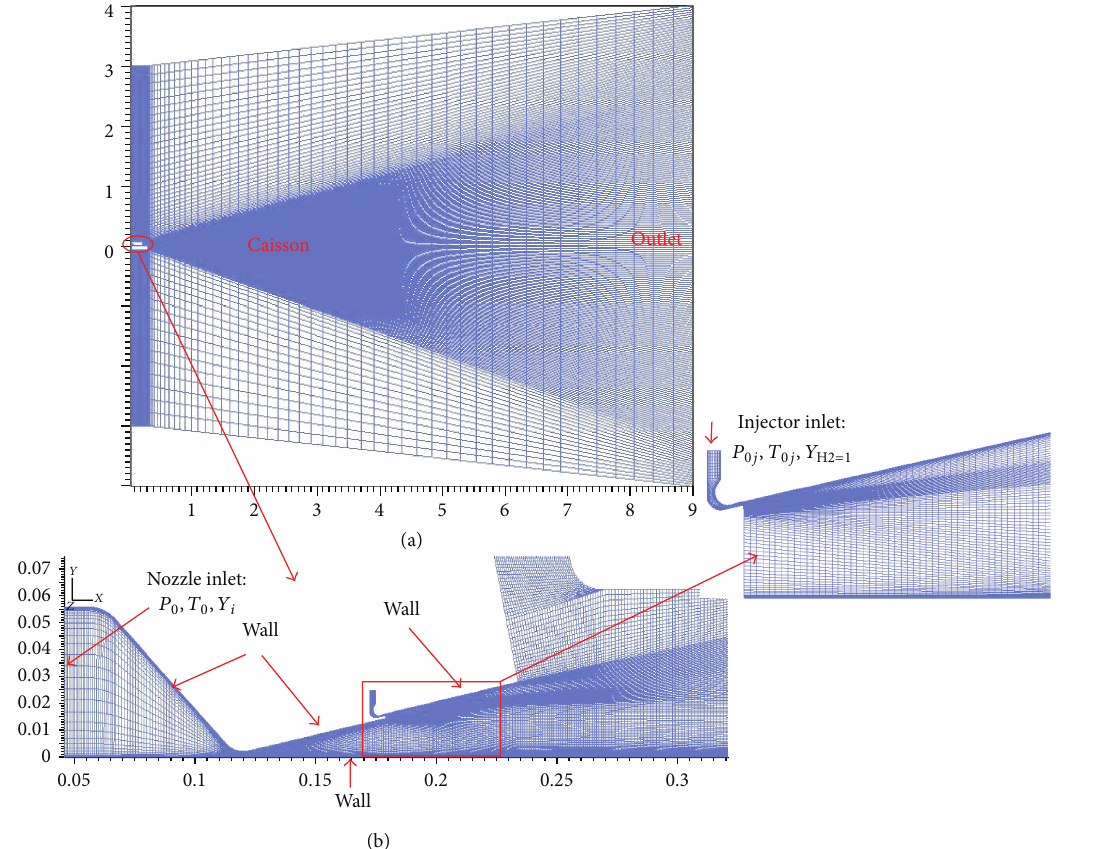
Figure 4: Grids system used for CFD calculation: (a) nozzle with part of the surrounding area, (b) nozzle with a zoom of the region near the injection slot.